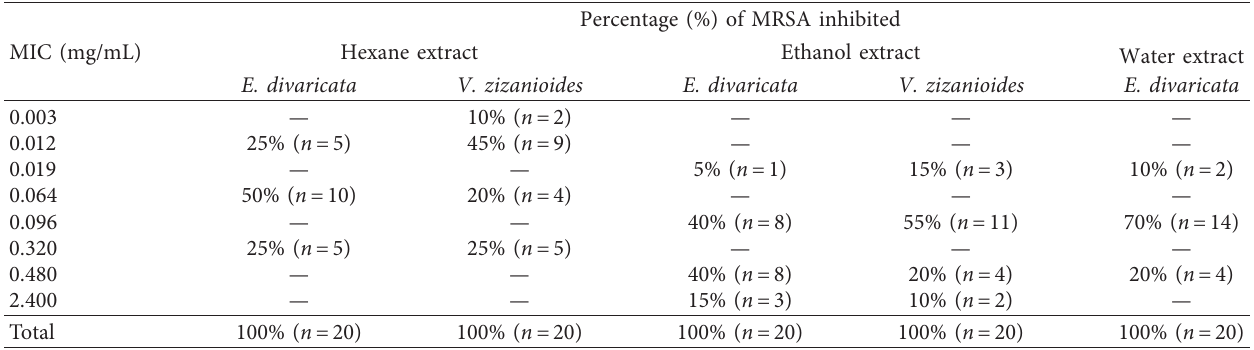
Table 3: Percentage of MRSA strains inhibited at different MIC values of E. divaricata and V. zizanioides . Percentage (%) of MRSA inhibited MIC (mg/mL) Hexane extract Ethanol